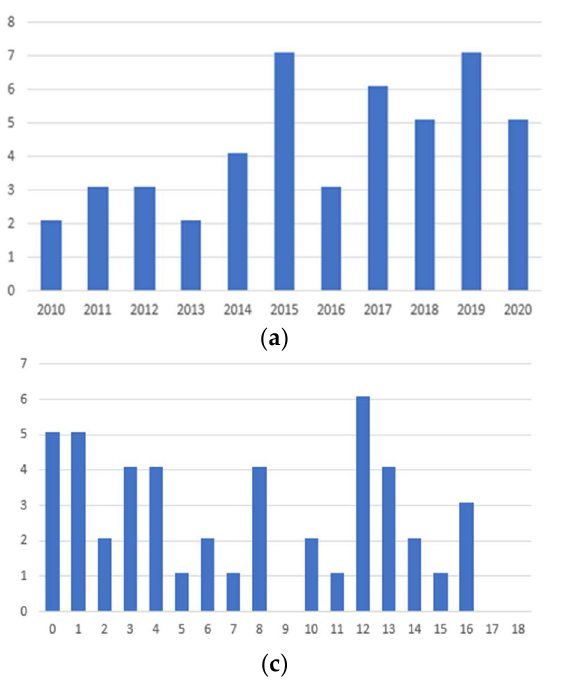
Figure 1. Distribution of cases per year ( a ), per month ( b ) and for age ( c ) in our 47 patients affected by pelvic pyomyositis.